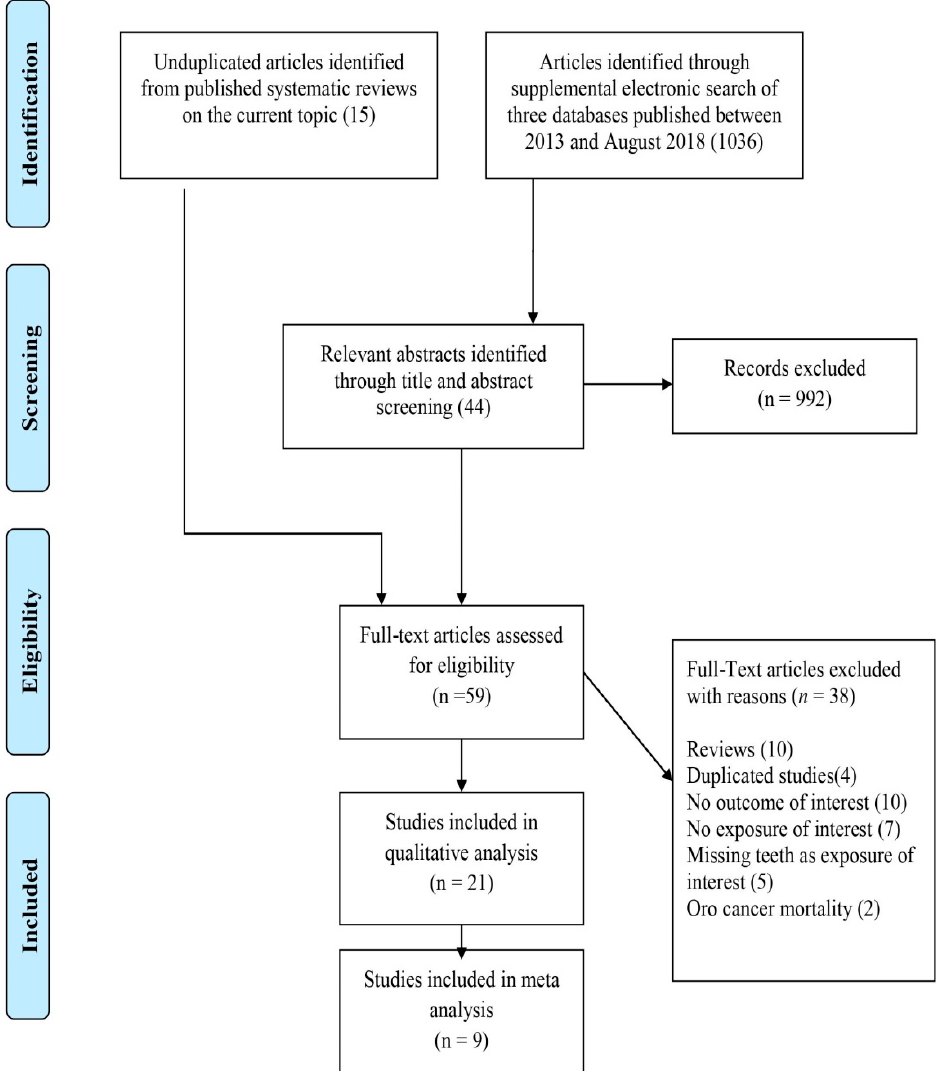
Figure 1. PRISMA flow diagram for systematic review depicting phases of identification of studies.